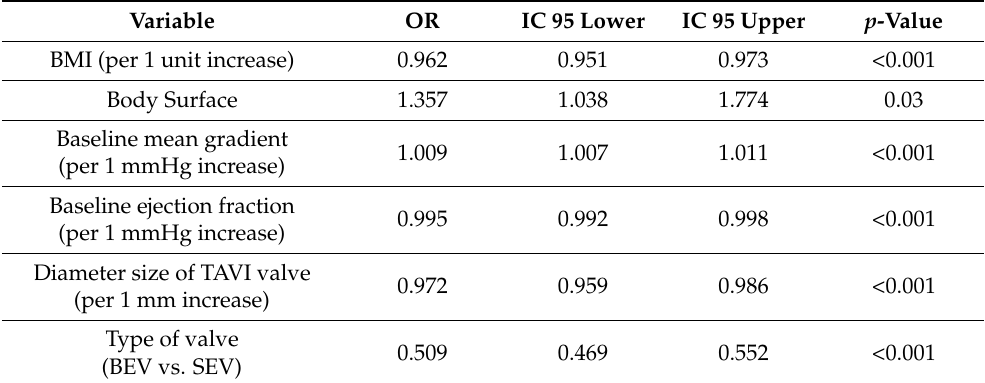
Table 4. Multivariate adjustment of predictors of